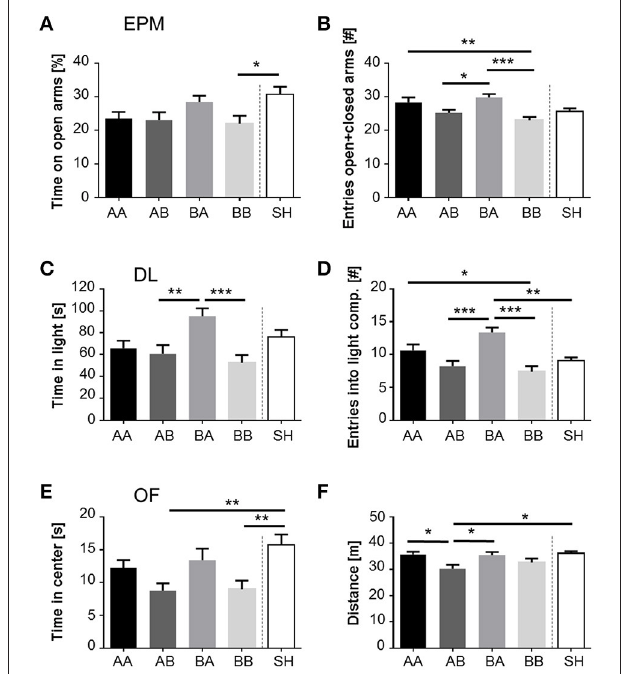
FIGURE 3 | Impact of life history on anxiety-like behavior and exploration. (A) Time spent on open arms of EPM, (B) Sum of entries into open and closed arms of EPM, (C) , Time spent in and (D) Entries into light compartment of DL, (E) Time spent in center and (F) Distance traveled in OF, displayed by male mice grown up in an early adverse (AA and AB) or beneficial (BA and BB) environment and provided with later matching (AA and BB) or mismatching (AB and BA) living conditions in adulthood. Data are given as means + SEM. Statistics: ANOVA; post-hoc testing: Bonferroni. * p < 0.05; ** p < 0.01; *** p < 0.001. Animals per group: AA = 28, AB = 27, BA = 28, BB = 27, SH =